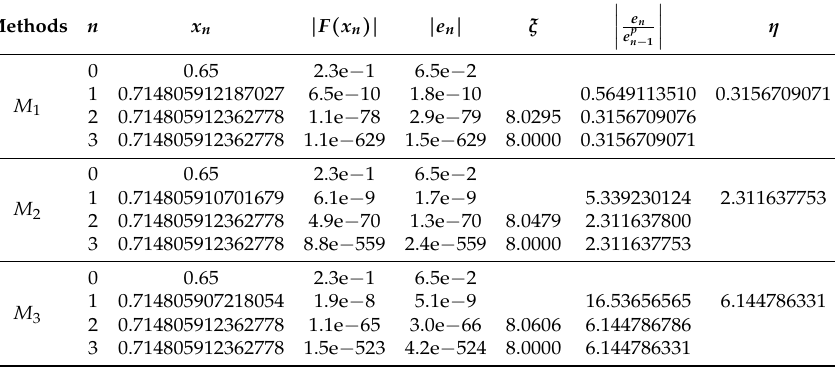
Table 6. Convergence behavior of different cases on Example